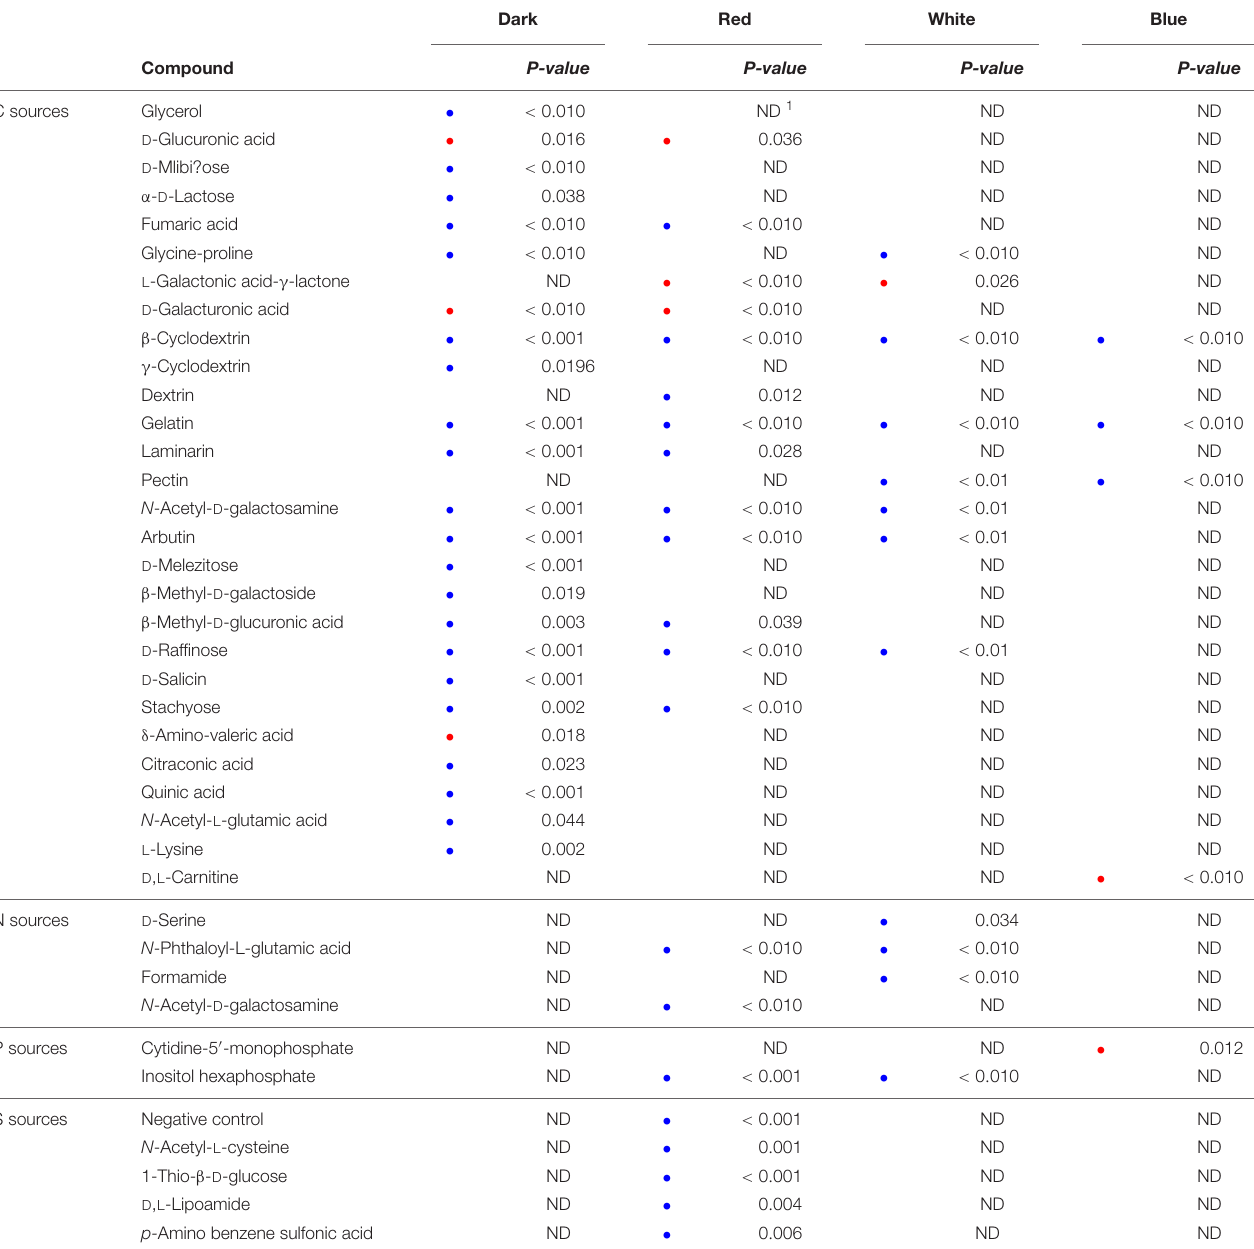
TABLE 2 | Comparison of substrate utilization by the control strain and Pseudomonas agarici , analyzed by T -test based on six individual replicates.